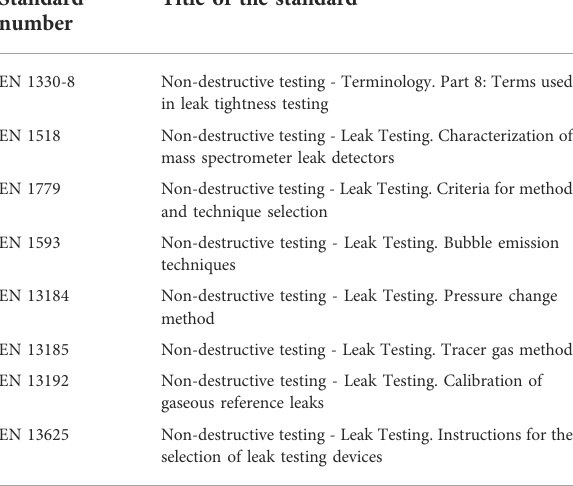
TABLE 4 European Normative Standards related to non-destructive leak testing. The table is adapted from (Schroder, 2001). Standard